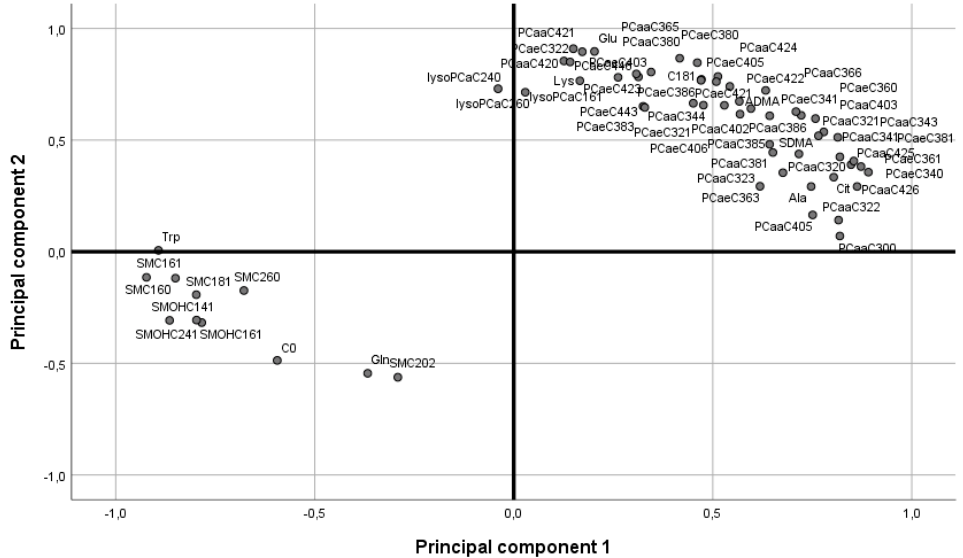
Figure 3. Unsupervised principal component analysis of significantly different metabolites (n = 62) between BWM and RYGB rats. The first component explains 52% of the variation, and the second component 22%. C, acylcarnitine; lysoPC, lysophosphatidylcholine; PC aa, phosphatidylcholine with ester bonding; PC ae phosphatidylcholine with ether bonding; SM, sphingolipid.